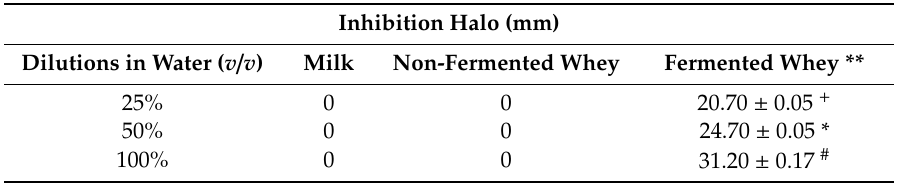
Figure 2. Inhibition halos of different bacteria exposed to 120 h fermented whey. Chlorine was used as a positive control. Results are the average of three replicates ± standard deviation. Note: NI = No inhibition observed. Table 2. Halos of inhibition of L. monocytogenes growth exposed to 120 h fermented whey, milk, or non-fermented whey diluted in water.